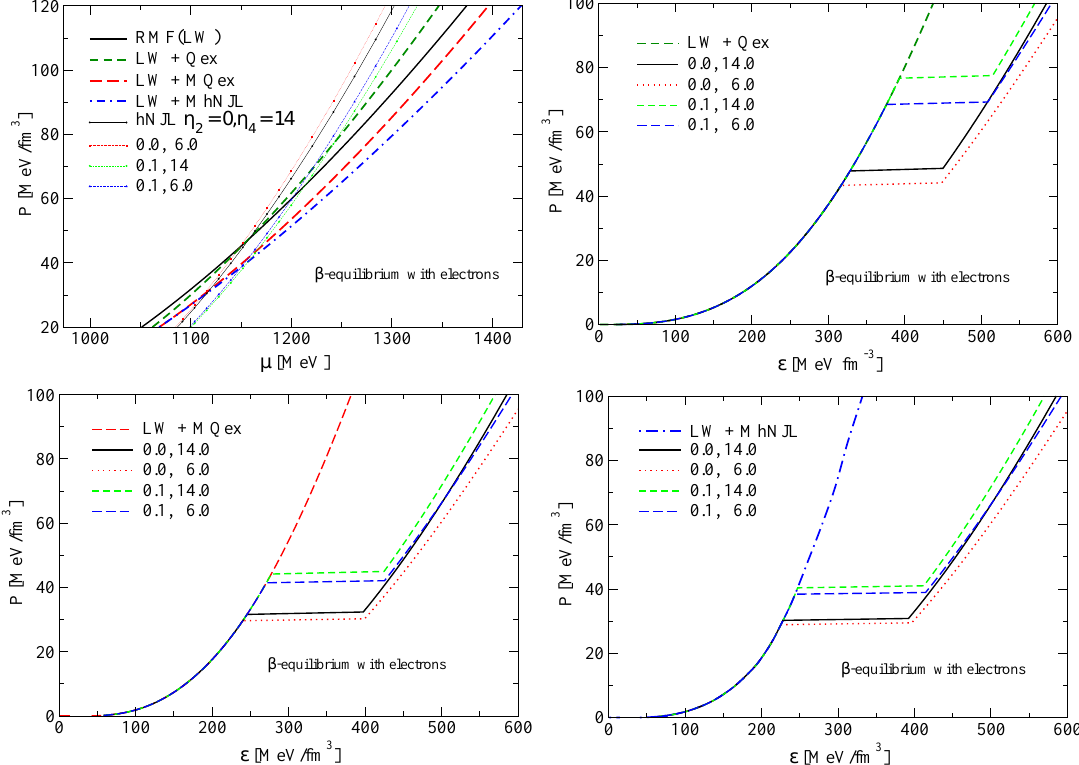
Figure 10. Upper left panel: Maxwell construction of the first-order phase transition in the pressure-chemical potential plane. The crossing points of the parameterizations of the hNJL quark matter model with the hadronic EoS models define the values for the critical pressure and the critical chemical potential where the system switches from the hadronic to the quark matter phase, described by the corresponding EoS. Upper right panel: first order phase transitions from the hadronic model LW + Qex to hNJL quark matter with four parametrizations in the pressure-energy density plane. Lower left (right) panel: same as upper right panel, but for the hadronic model LW + MQex